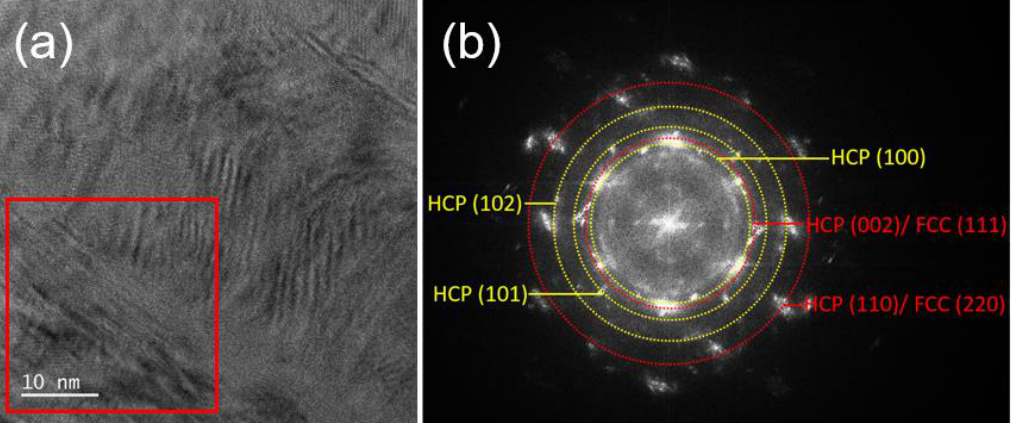
Figure 6. ( a ) HRTEM of S14; ( b ) the corresponding pattern of the red-square region on the left side. The lattice parameters of the samples estimated by the diffraction peaks in the GIXRD patterns are tabulated in Table 2. The average lattice parameter of the 16 samples was calculated to be a FCC = 3.57 Å . In addition, for samples having an HCP phase, i.e., S14, the lattice parameters of the HCP phase were calculated as a HCP = 2.53 Å and c HCP = 4.10 Å , which are in agreement with those of the JCPD database.